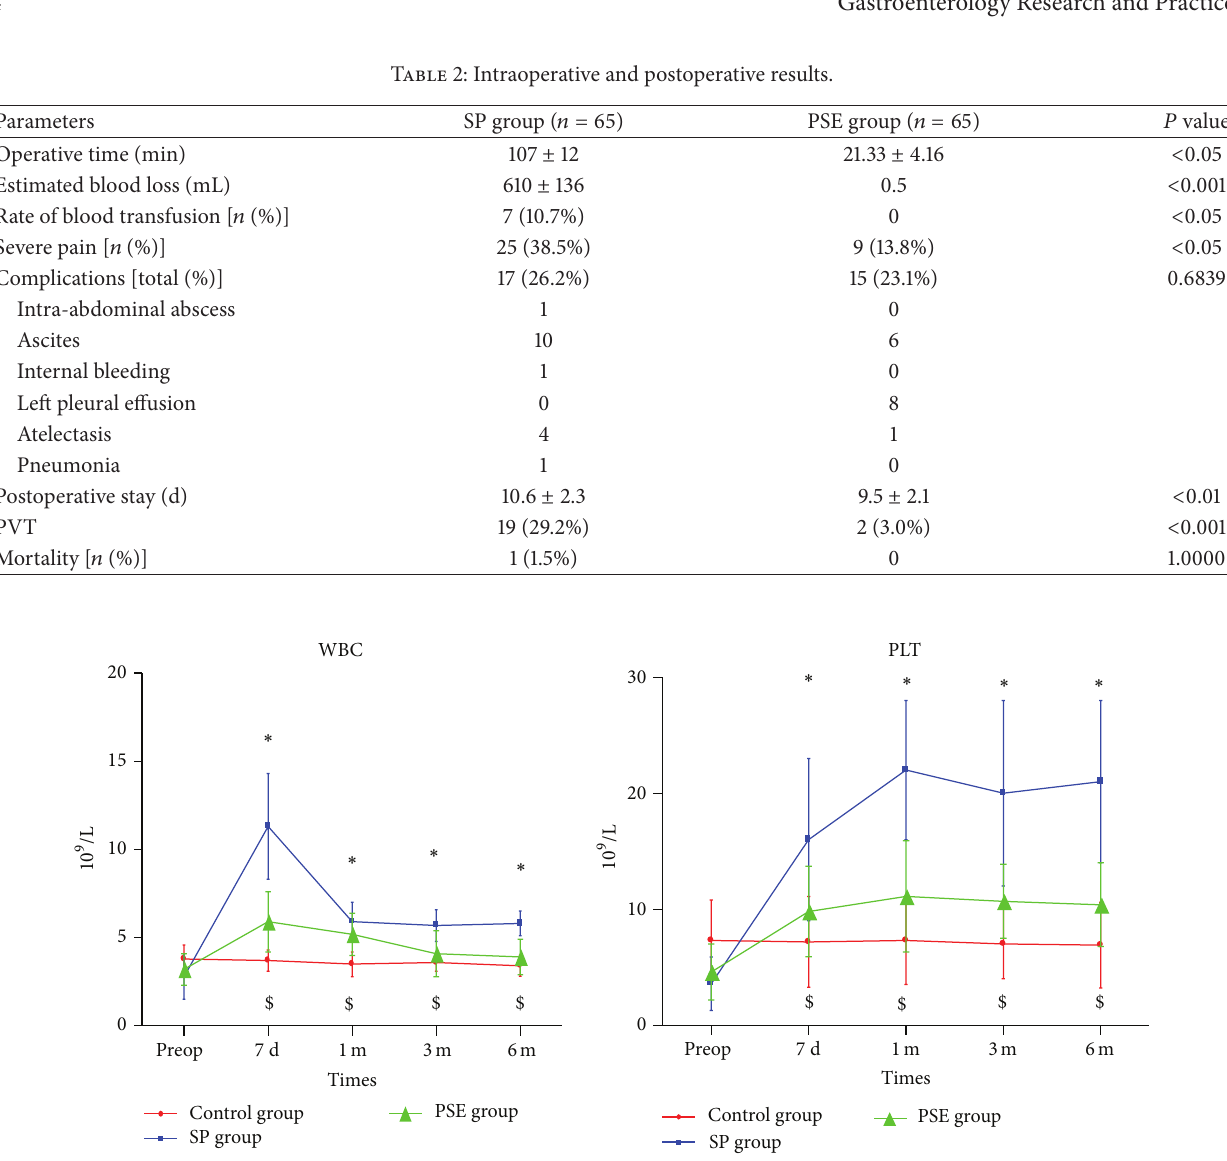
improvement was indistinguishable between the SP and PSE groups ( 𝑃 > 0.05